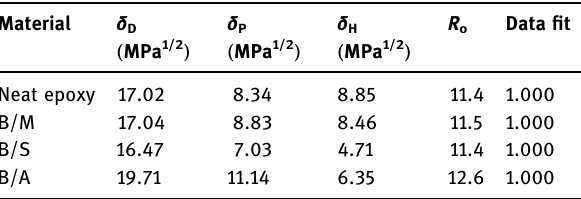
Table 2: HSP values for neat epoxy and core/shell nanoparticles Material δ D ( MPa 1/2